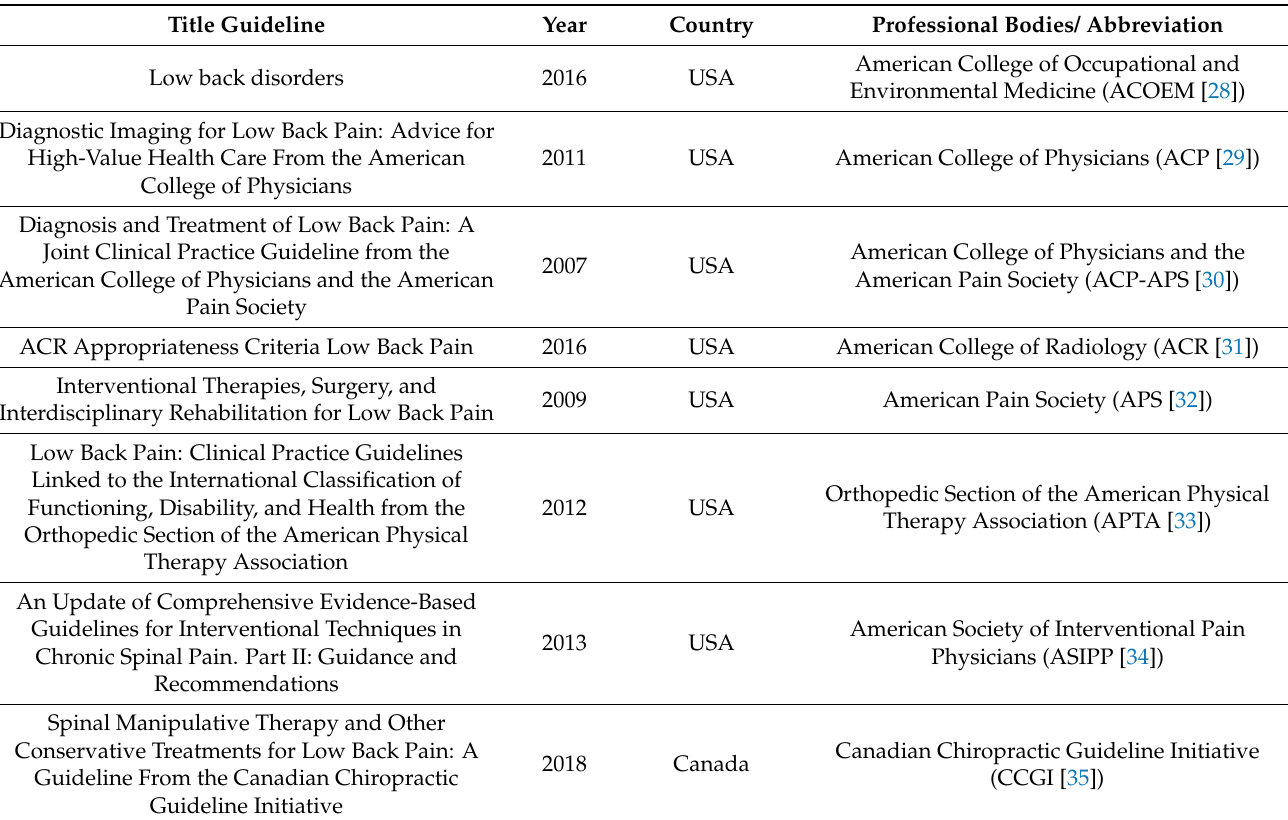
Figure 1. Preferred Reporting Items for Systematic Reviews and Meta-Analyses (PRISMA) flow diagram. Table 1. Characteristics of included clinical practice guidelines on recommendations for patients with lumbar radicular pain ( n =